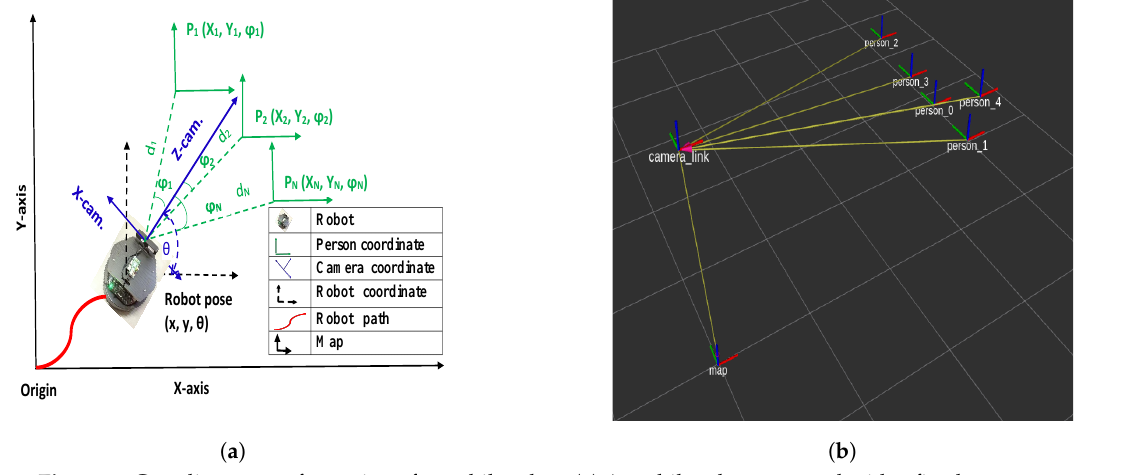
Figure 5. Coordinate transformation of a mobile robot. ( a ) A mobile robot mounted with a fixed camera on a 2 D plane. ( b ) A view of the standard transform library (tf) tree in the tf rviz